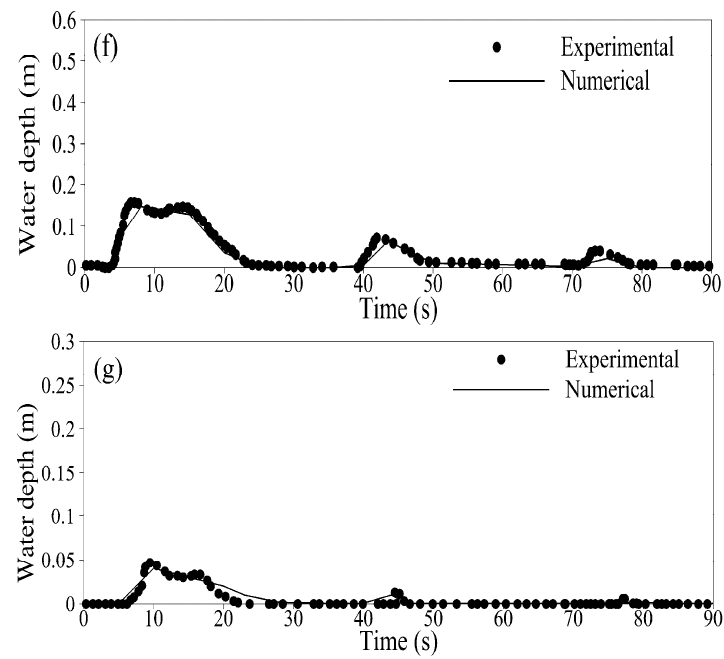
Figure 14. Comparison of water surface elevation with experimental measurements at seven gage locations. ( a ) gage 1 at 2 m downstream of dam; ( b ) gage 2 at 4 m downstream of dam; ( c ) gage 3 at 8 m downstream of dam; ( d ) gage 4 at 10 m downstream of dam; ( e ) gage 5 at 11 m downstream of dam; ( f ) gage 6 at 13 m downstream of dam; ( g ) gage 7 at 20 m downstream of dam.